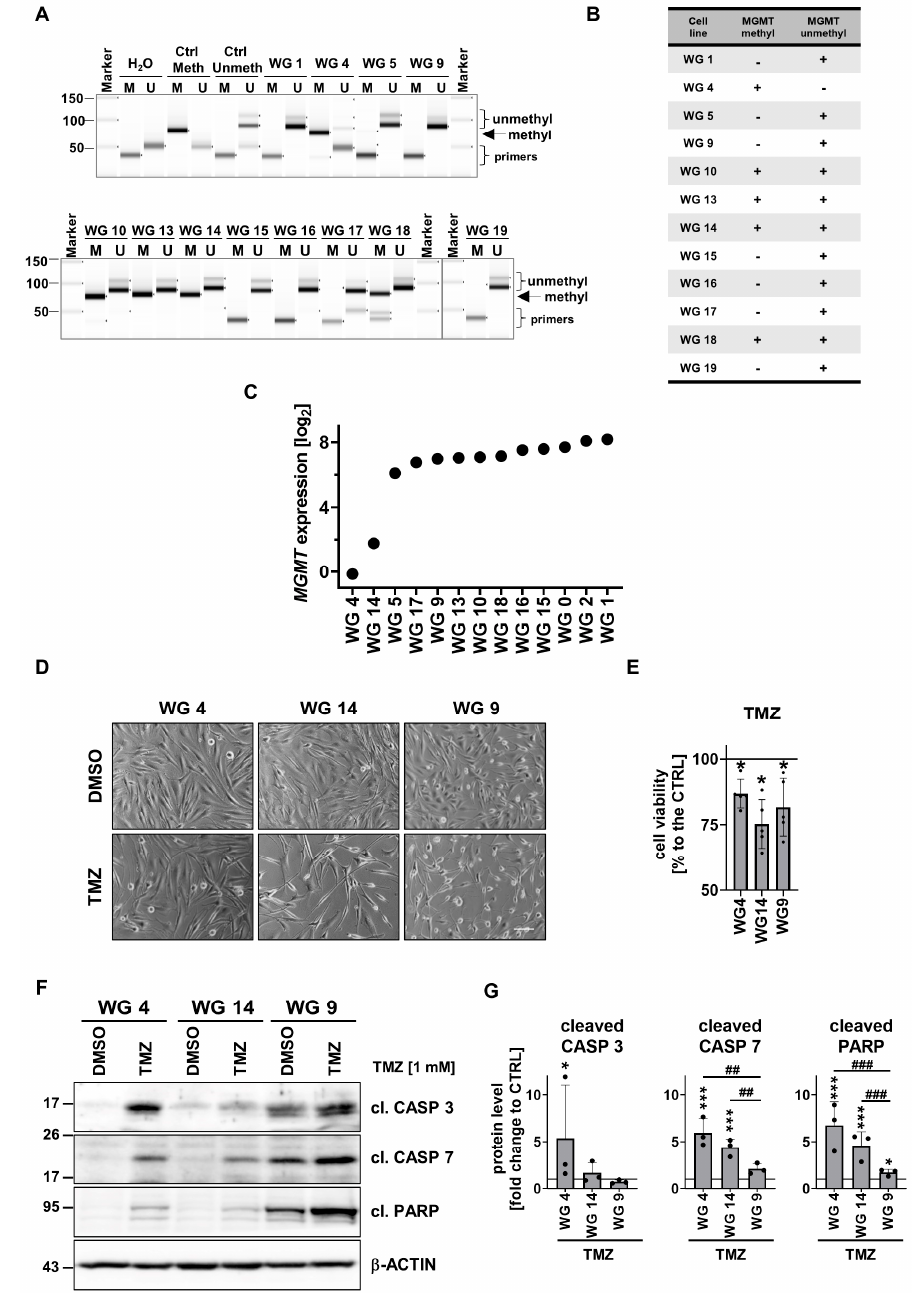
Figure 5. MGMT promoter methylation and the impact of TMZ on primary glioma cell cultures. ( A ) Evaluation of the MGMT promoter methylation in primary glioma cell cultures and ( B ) a summary table. ( C ) MGMT expression in primary glioma cell cultures based on RNA-seq analysis. ( D ) Microscopic images of WG4, WG14 and WG9 treated with TMZ (1 mM, 72 h). Scale bar: 100 µm. ( E ) Viability of WG4, WG14 and WG9 cells after TMZ treatment, determined by MTT metabolism test. The viability of untreated cells was set as 100% and marked with a black solid line. Statistical analysis